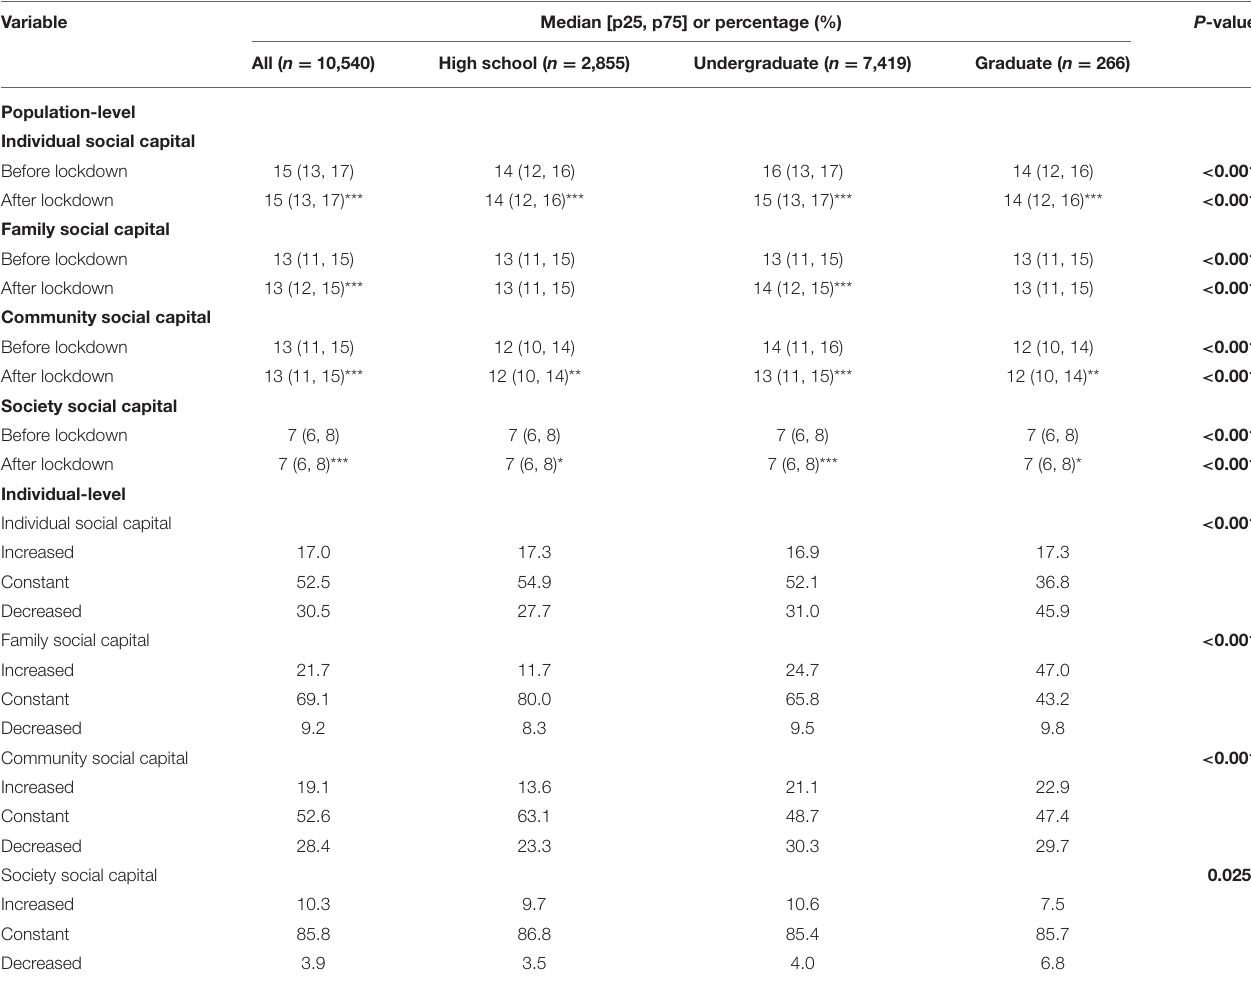
TABLE 3 | Changes in social capital before and after the COVID-19 lockdown among the participating youths in the COVID-19 Impact on Lifestyle Change Survey (COINLICS).